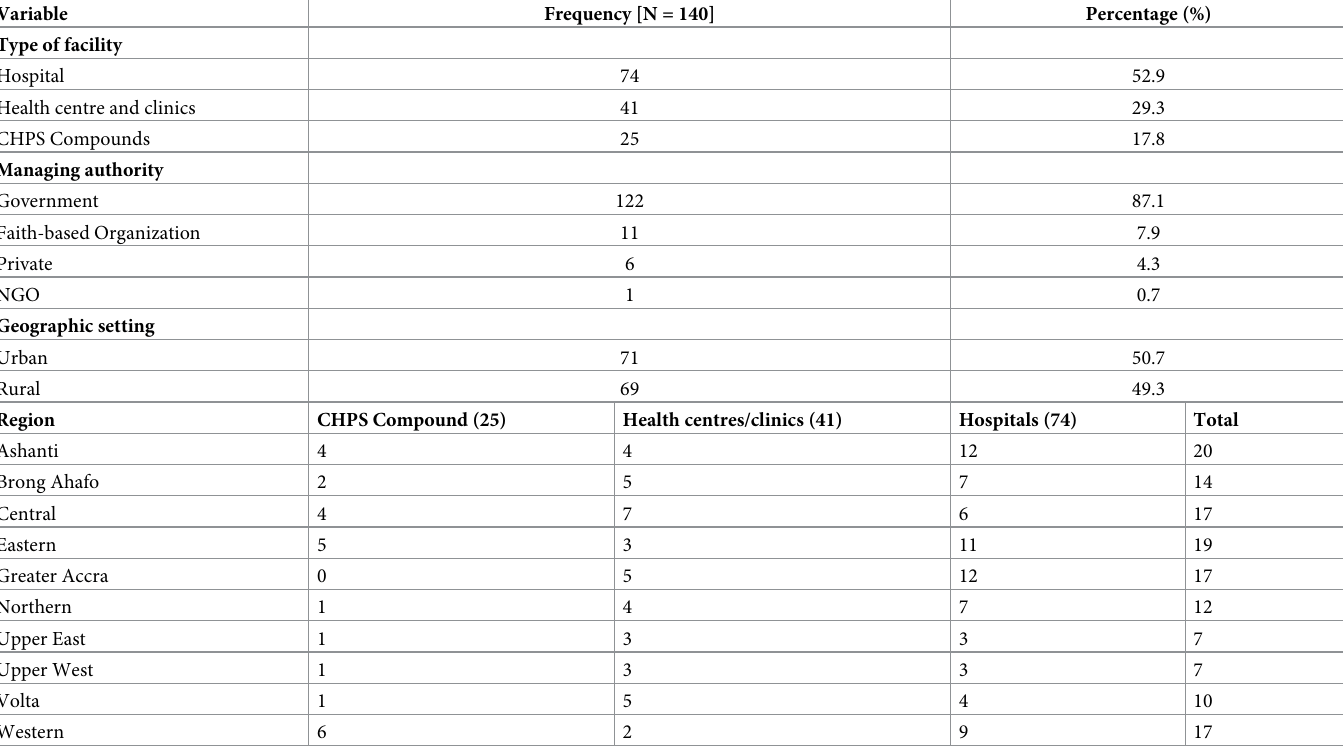
Table 2. Background characteristics of